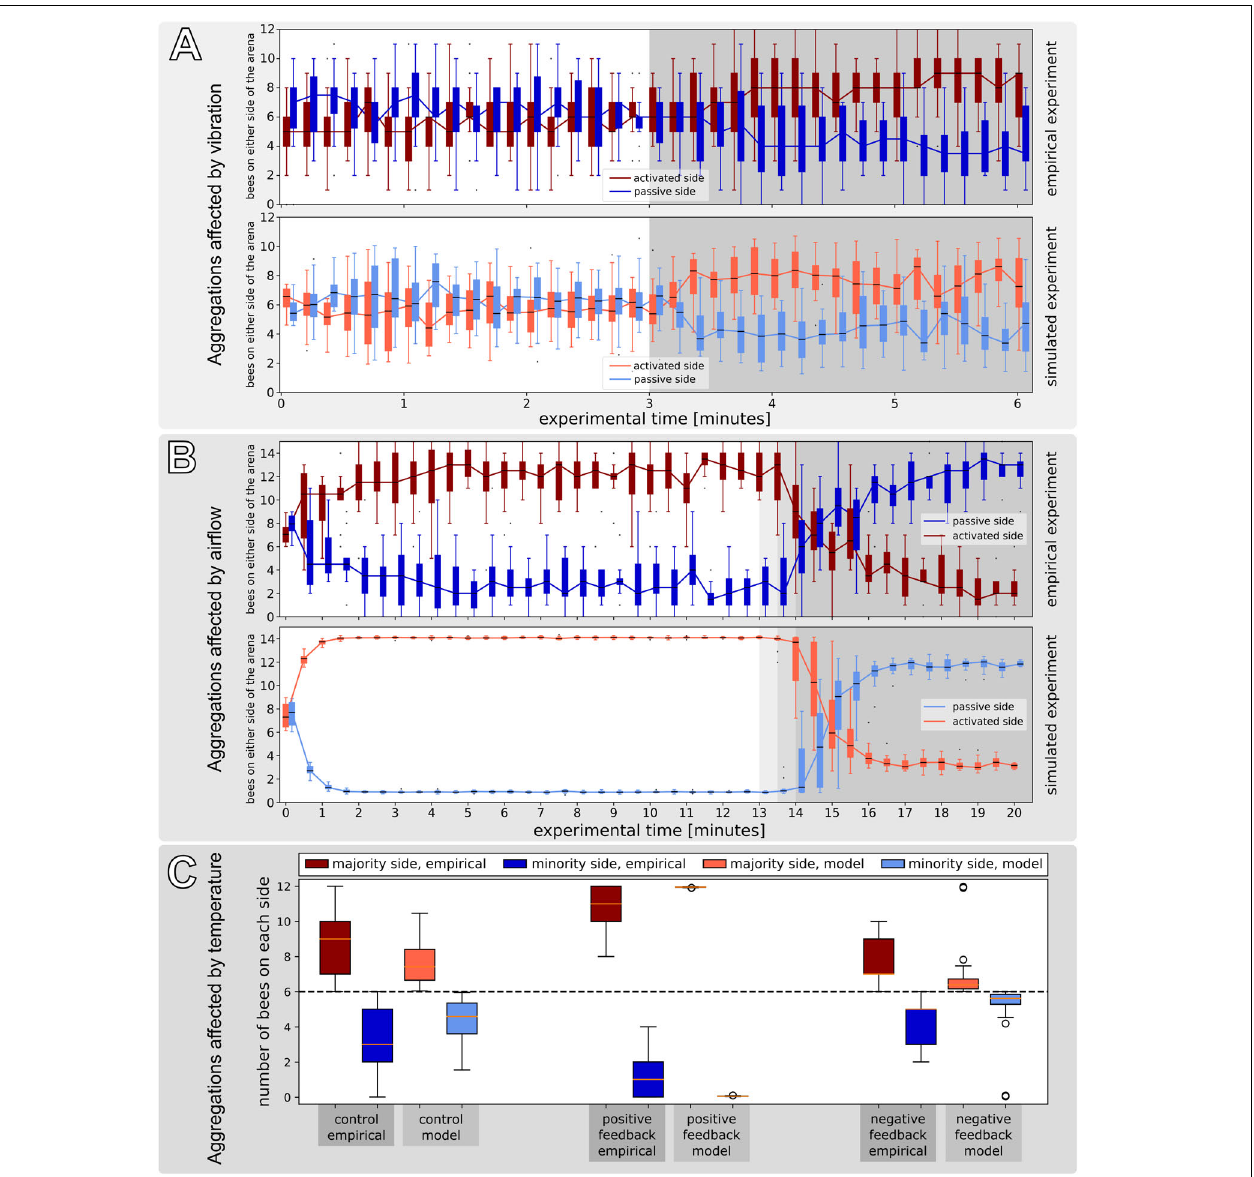
FIGURE 8 | Effects of vibration, airflow stimulation and temperature on honeybee groups in empirical experiments and in our mathematical model. (A) Vibrational patterns were used to guide aggregation by moving the bees from an even distribution around the robots to an uneven distribution ( N = 17 independent repetitions). The duration of the active vibration is indicated in the diagrams by the grey background: [ ψ active ( t ) = 0 . 1 for t ∈ ( 181 , 360 ) ]. In the first half of the experiment [ ψ active ( t ) = 0 for t ∈ ( 0 , 180 ) ], the bees move around freely and do not show any preference for one side of the arena. After the activation of the vibration (at time t = 181), there are more bees on the vibrating side in both the empirical experiments and the mathematical model. (B) In this experiment, an airflow stimulus was used to reverse initial decision making of honeybees in a temperature field containing a global optimum temperature (36 ◦ C at the “activated side” of the arena) and a local optimum (32 ◦ C, “passive side” of the arena), with N = 12 repetitions. The airflow was switched on at the robot on the warmer side to guide dispersal, which happened in the empirical experiments at different times between minute 13 and minute 15 as indicated by the grey background. This airflow stimulus remained active for the rest of the experiment. In the first phase of the experiment, more bees clustered around the warmer robot, while after activation of the airflow stimulus at this robot, bees increasingly dispersed and then aggregated around the other, cooler robot without airflow stimulus. These dynamics are replicated in the model results (lower sub-panel). (C) Honeybee group decisions in modelling a robot-mediated thermal environment with closed-loop control and how this agrees with empirical data (empirical experiments, reported in Stefanec et al., 2017a), and how the modelling results agree with empirical trends. N = 14 independent repetitions in each setting. Since the binary choice offered to the bee groups is not a priori biassed for one side or the other, we report the number of bees on the majority and minority sides within each repetition; the analysis covers the last 5 min. Three variants of the robot controller, as described in the text, lead to qualitatively different collective decisions by the honeybee group. Specifically, positive feedback linking the local temperature to the local bee density causes strong decision making; negative feedback between bee density and temperature prevents aggregations from building up; the control runs with constant 28 ◦ C temperatures throughout are in between and with more variable distributions. The main differences in how strong decision making occurs are reproduced by the model, although once again we see that the variance of distributions from the model, is substantially reduced in comparison with the empirical